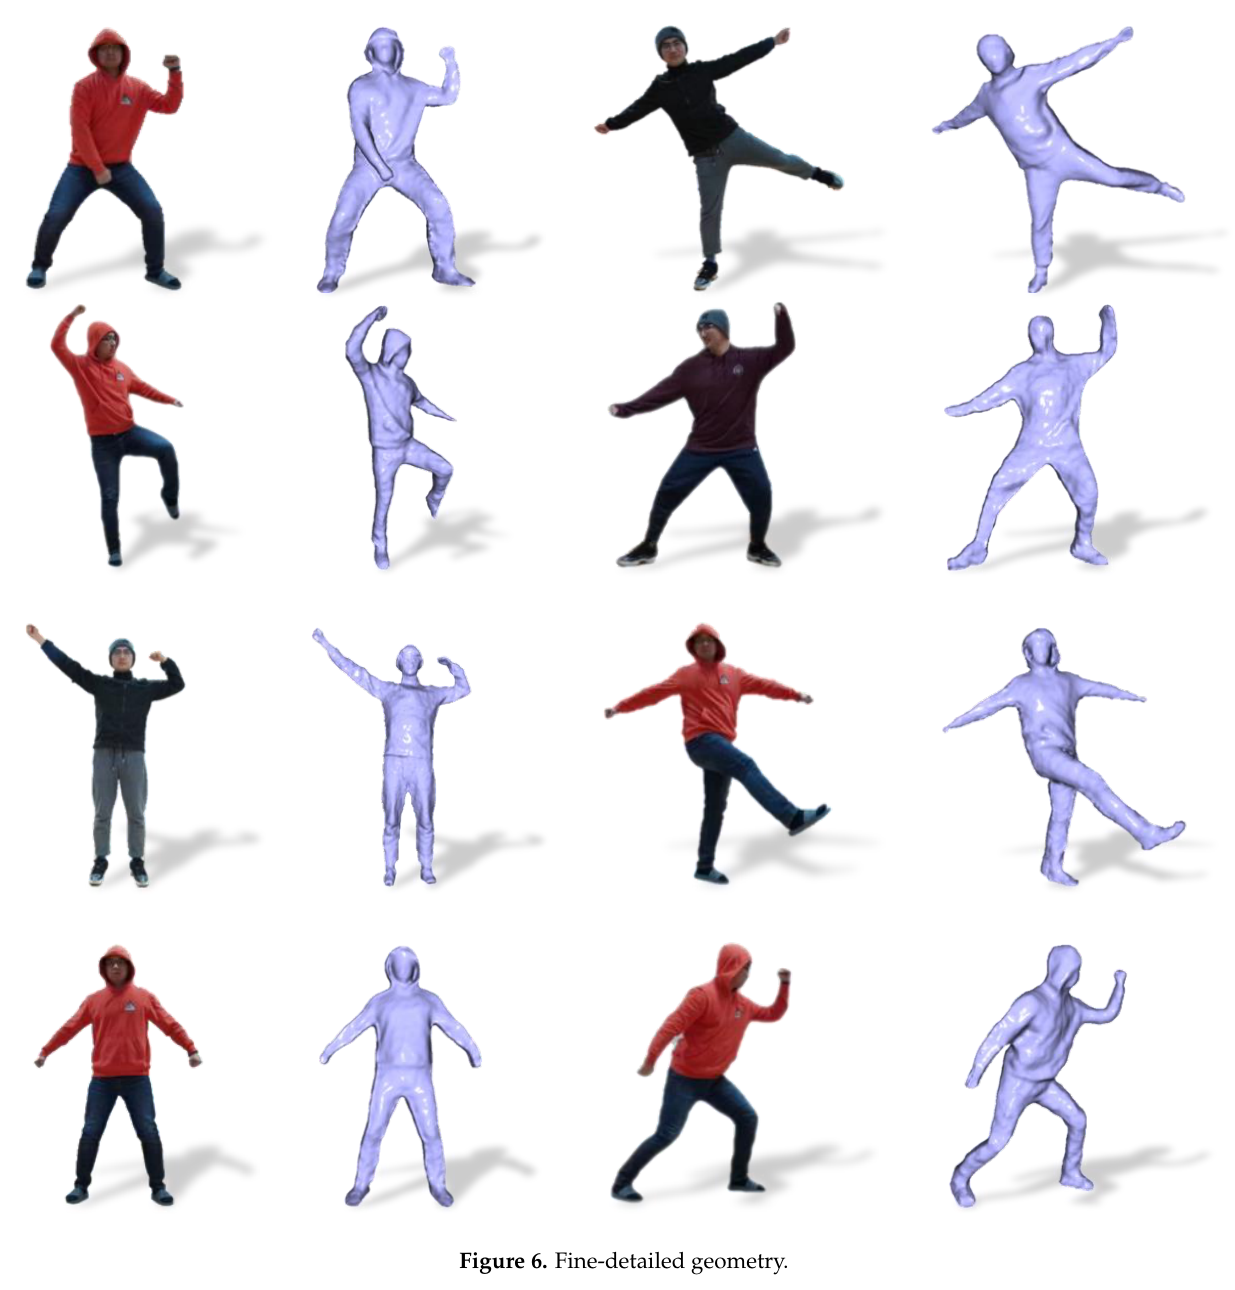
Figure 6. Fine-detailed geometry.